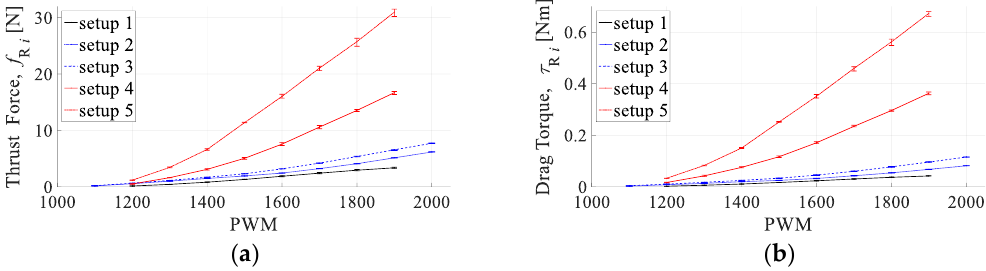
Figure 4. EPU static maps: ( a ) thrust force; ( b ) drag torque.